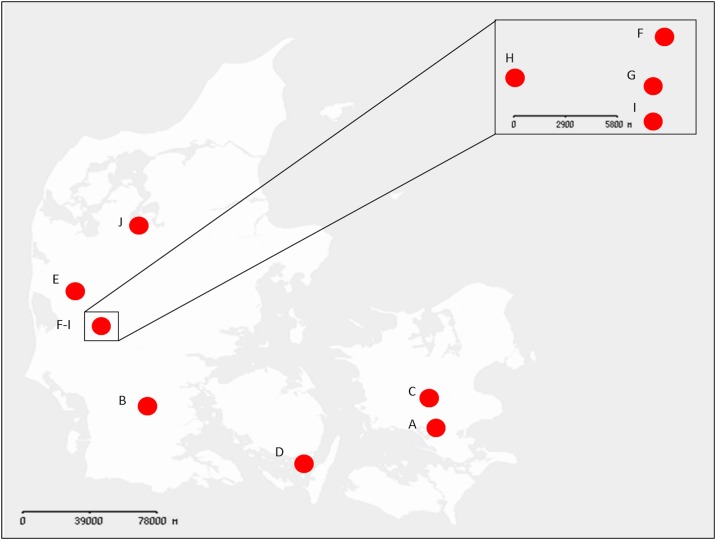
Map of locations from where flies were collected.From each location (red circles) the microbiota of 7–10 male flies were established (A = 8; B = 7; C = 8; D = 10; E = 9; F = 9; G = 9; H = 10; I = 10; J = 10). Locations are designated with a letter (A-J). DNA was extracted from whole flies. In total 10 locations (dairy farms) were sampled throughout Denmark, where 4 locations (F-I) were in close proximity of each other (< 10 km). A GeoDanmark Basis map was downloaded from the Danish “Geodatastyrelsen”, October 2016, Styrelsen for Dataforsyning og Effektivisering. The figure is similar, but not identical to the original image, and is therefore for illustrative purposes only.